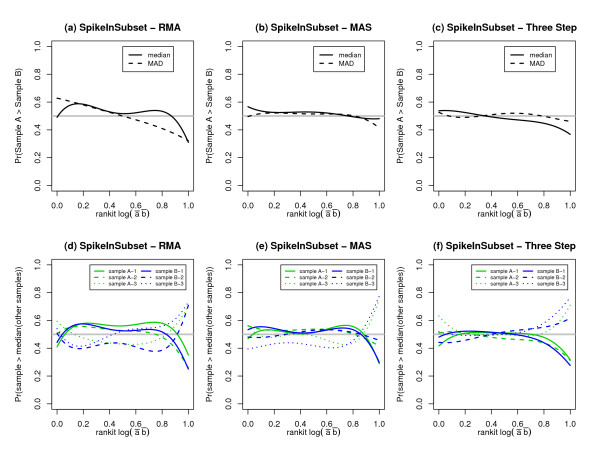
Diagnostic plots applied to the Affymetrix SpikeInSubset dataset. Axes for the top row of plots are as described in Figure 6. Axes for the bottom row of plots are as describes in Figure 7. The relative variability of the expression values appears to be intensity dependent when the data is normalized using RMA. Plots (d), (e), and (f) suggest that the intensity dependence is most notable at the extremes.